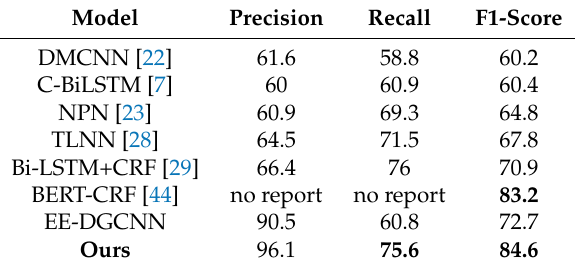
Table 8. Model performance